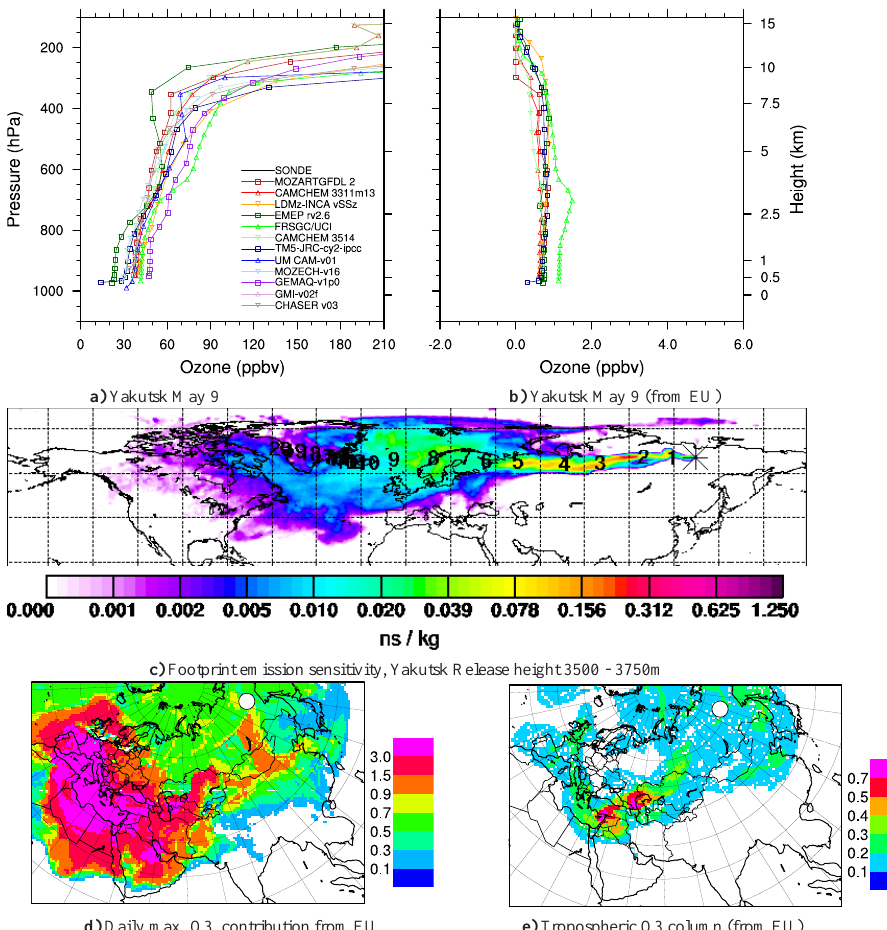
Fig. 15: All panels for May 9, 12 UTC. a) Ozone sounding and calculated vertical profiles in ppb for the 12 models listed in Table 1. b) Calculated difference SRref - SR20%EU in ppb for the 7 models, showing the effect of a 20% reduction of European emissions. c) Footprint emission sensitivity (release height 0 - 250m) from Yakutsk. in ns/kg (nanoseconds/kg). The asterisk marks the position of the ozonesonde site. d) Difference (SRref - SR20%EU) in daily maximum surface-ozone in ppb calculated with the EMEP model. e) Difference (SRref - SR20%EU) in tropospheric ozone column (DU) calculated with the EMEP model. White circle marks the position of Yakutsk in d) and e).